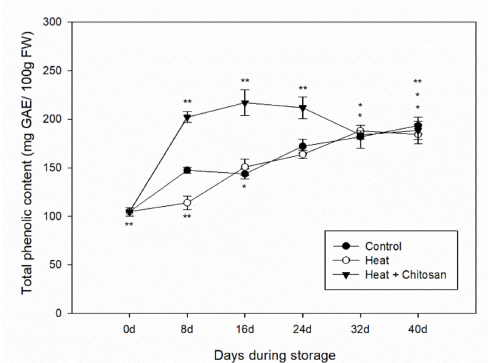
Figure 3. Total phenolic content of ‘Sanhua’ plum fruit during storage. Error bars represent for standard errors. Control: fruits without treatment; Heat: fruits with hot air treatment at 37 ◦ C for 6 h; Heat and Chitosan: fruits treatment with hot air (37 ◦ C, 6 h) and 1% chitosan. * and ** mean significant di ff erences at p < 0.05 and p < 0.01 level, respectively.